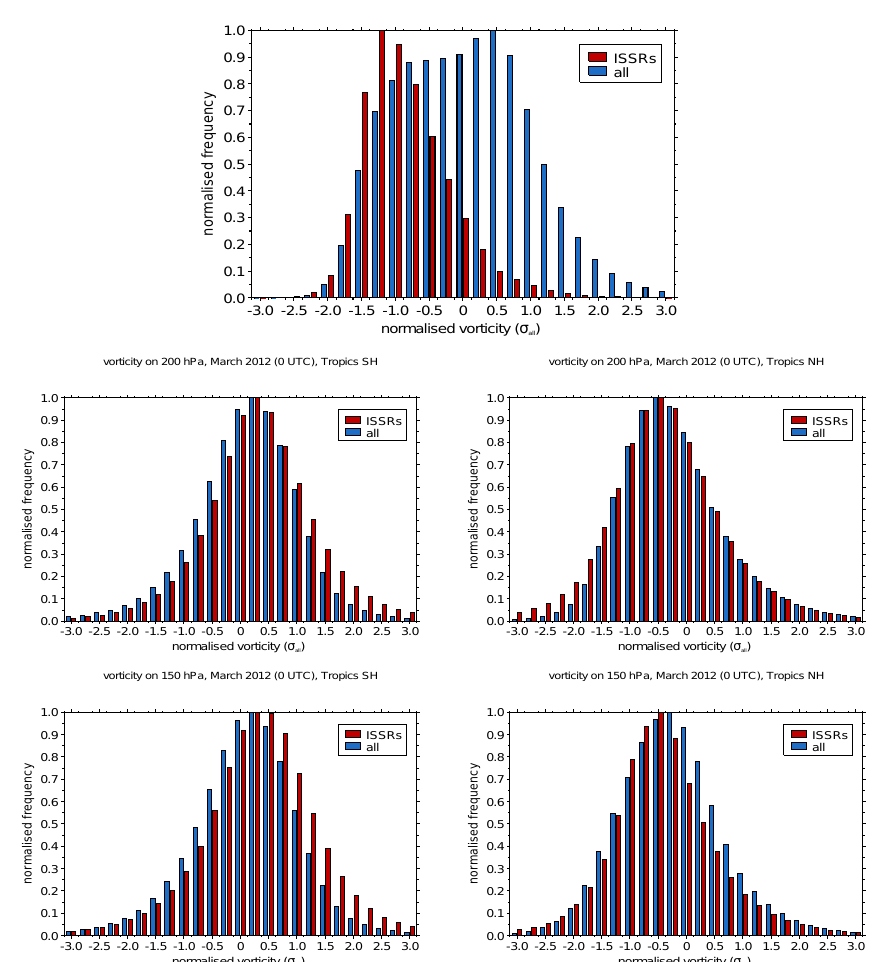
Fig. 2. As Fig. 1, but for relative Fig. 2. As figure 1, but for relative vorticity.